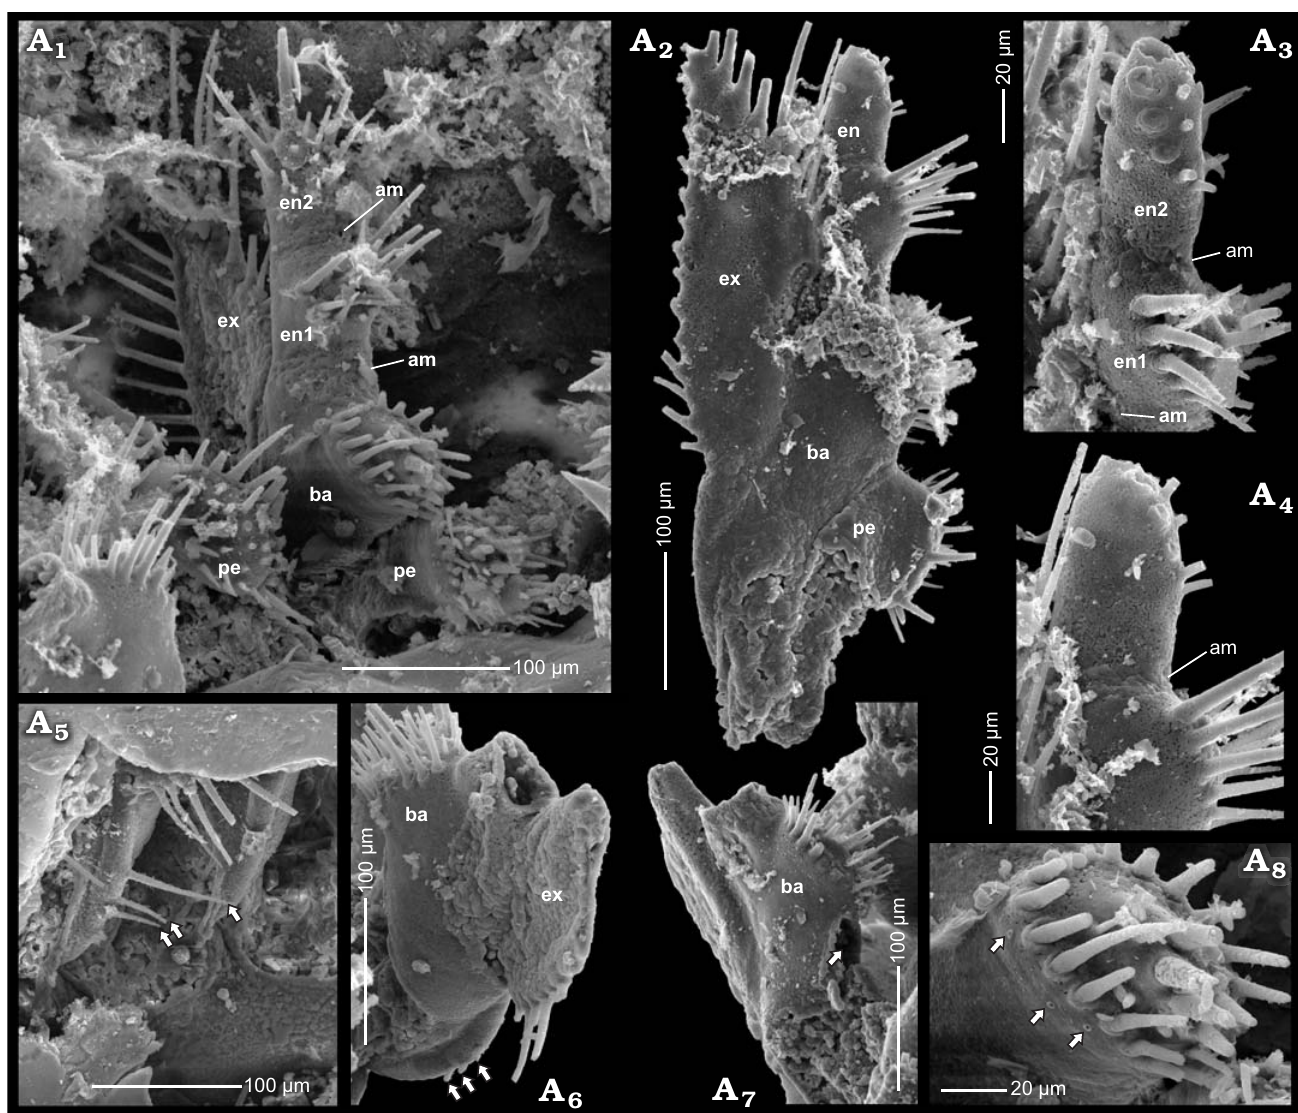
Fig. 5. Phosphatocopid crustacean Cyclotron angelini (Linnarsson, 1875), ZPAL Cr.11/ph060 from the Olenus Biozone, Furongian, D ę bki 2 borehole, northern Poland. First right post-mandibular limb in postero-median view (A 1 ); first left post-mandibular limb in anterior view, note large paddle-shaped exopod with few distal annuli, note arthrodial membrane between endopodal segments (A 2 ); detailed view of A 2 concentrating on two-divided endopod and arthrodial membrane between endopodal segments (A 3 , A 4 ); lateral basipodal margin of the second right post-mandibular limb, bearing three setae (arrows) (A 5 ); partly preserved second left post-mandibular limb in posterior view with three setae (arrows) on lateral margin of basipod in posterior view (A 6 ); and anterior view indicating place left by proximal endite broken off (arrow) (A 7 ); detailed view of A 1 , with setation and glandular openings (arrows) on posterior side of basipodal endite (A 8 ). Abbreviations: am, arthrodial membrane; ba, basipod; en, endopod; ex, exopod; pe, proximal